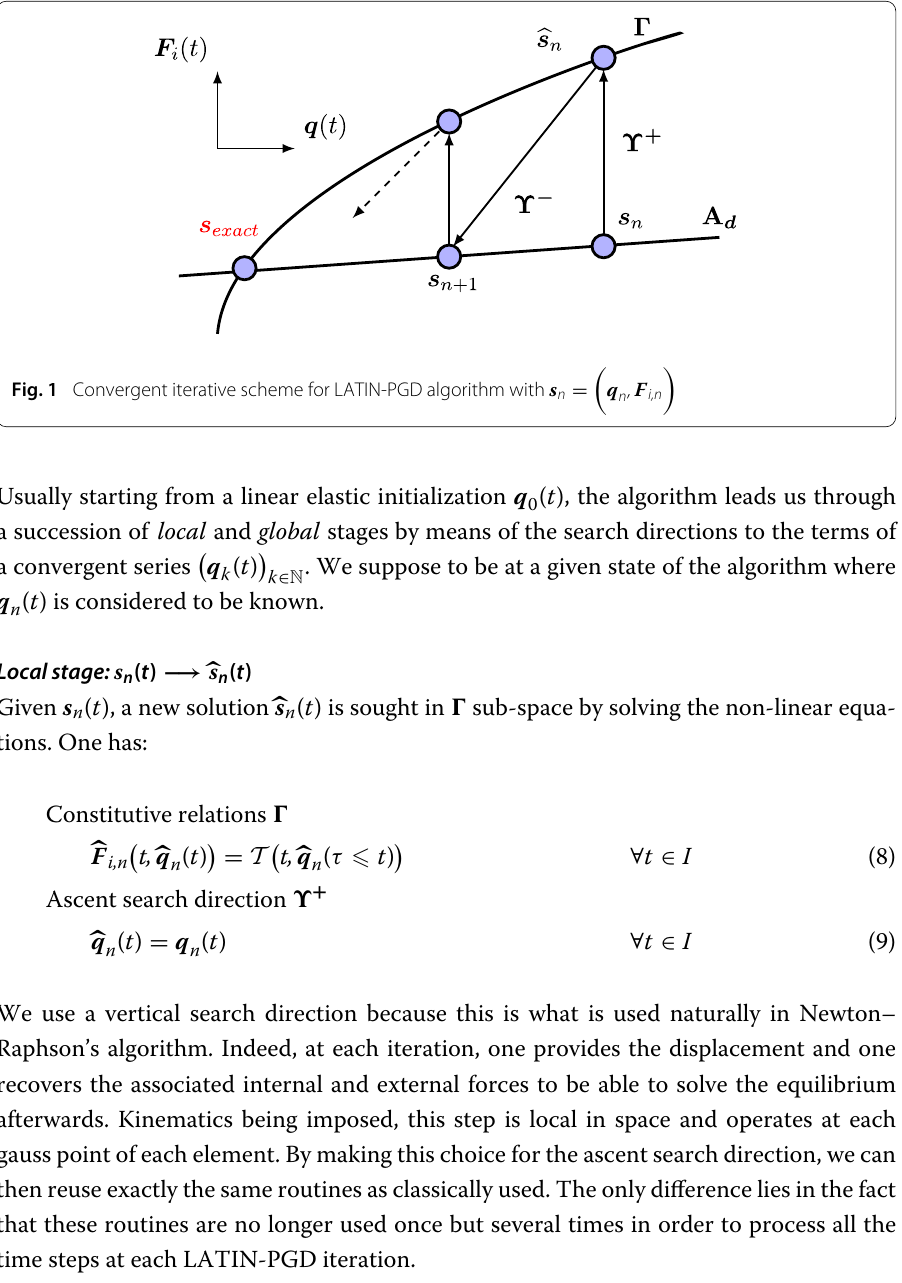
(cid:4) q n , F i,n